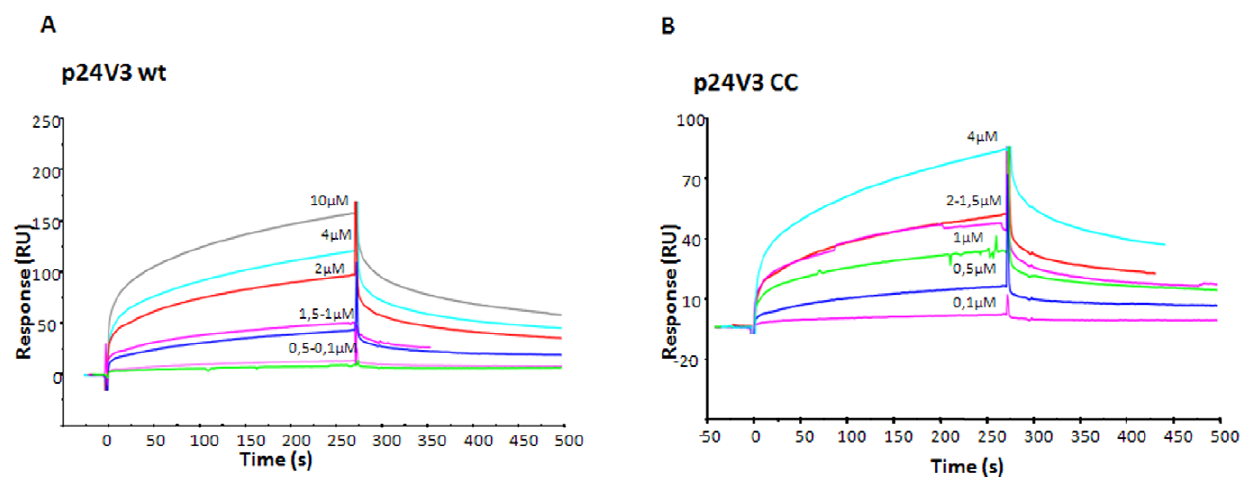
Figure 9. SPR analysis of anti-V3 447-52DmAb with p24:V3 chimera. Overlay of sensorgrams relative to the direct binding of p24:V3 wt ( A ) and p24:V3 CC ( B ) to immobilized antiV3 447-52D (3219) mAb. Concentrations were reported on the sensorgrams. Experiments were carried out in duplicate, at a 25 u C, at a constant flow rate of 20 uL/min using HBS as running buffer.